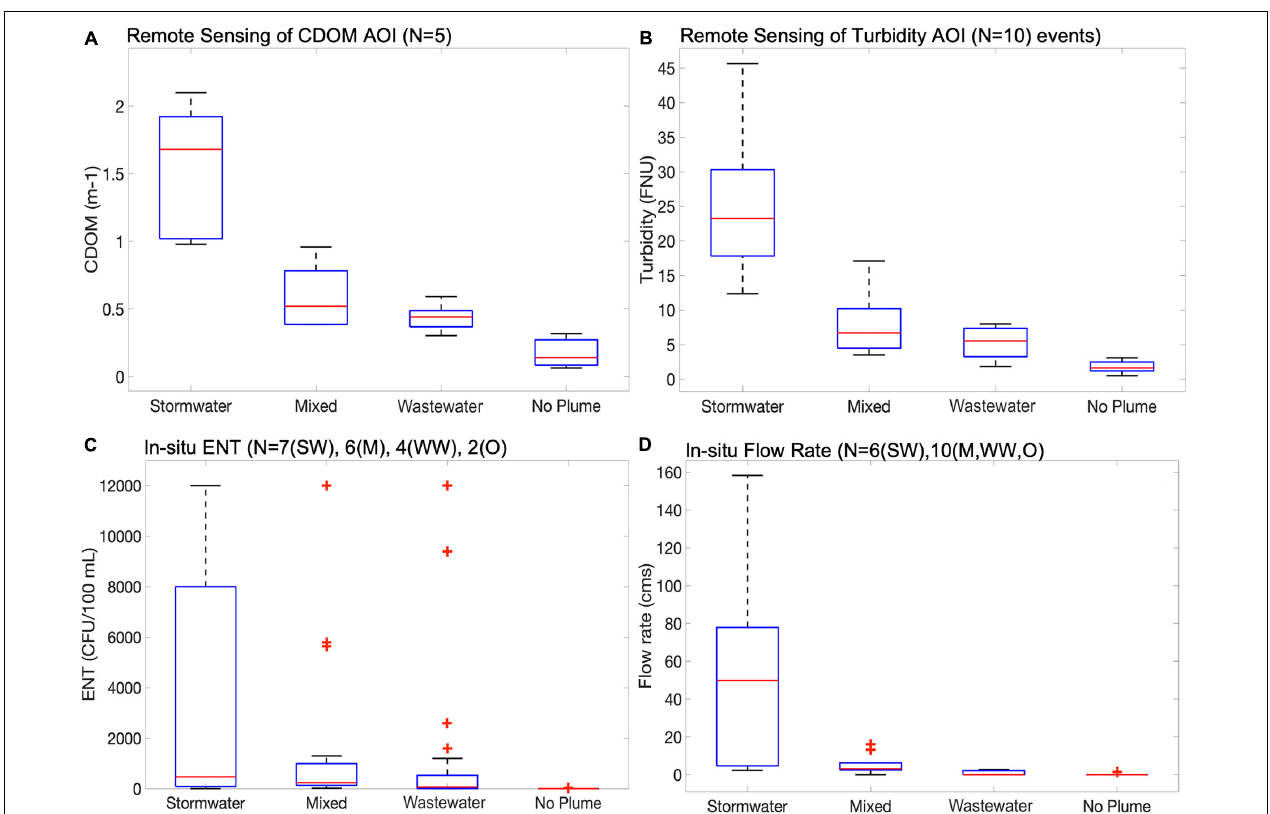
FIGURE 5 | Box plots of CDOM and turbidity derived from remote sensing data, and ENT and flow rate from in situ measurements. (A) Mean derived CDOM from AOI (Lee et al., 2002) for 5 stormwater, 5 mixed, 5 wastewater, and 5 no plume events using Landsat 8 and Sentinel 2 A/B data (more information: Supplementary Table 3 ). (B) Mean derived turbidity from AOI (Nechad et al., 2009) for 10 stormwater, 10 wastewater, 10 mixed, and 10 no plume events using RapidEye data. (C) Enterococcus (ENT) counts for 7 stormwater, 6 mixed, 4 wastewater, and 2 no plume events (more information: Supplementary Table 2 ). (D) Mean flow rate from gauge station ( Figure 1 : green star) in cubic meters per second (cms) from 12 h prior to the satellite revisit time for 6 stormwater events and 10 wastewater, 10 mixed, and 10 no plume events). For each box plot, the median is shown by the red mark, the whiskers correspond to the maximum and minimum values, the red plus signs show the outliers outside of the 25–75 percentile range shown by the